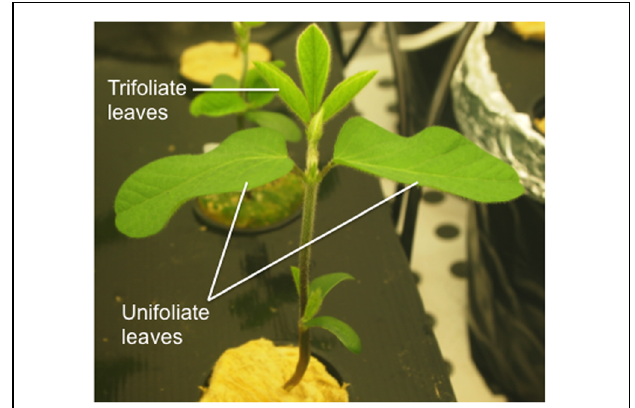
FIGURE 1 | Efficient accession soybean plant 437929 at V1 stage of development (as described by Fehr and Caviness, 1977) showing fully expanded unifoliate leaves and one unfolded